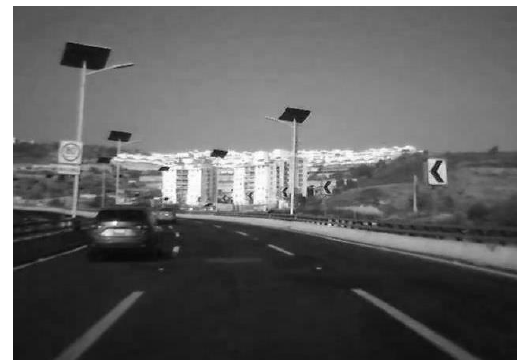
Figure 5. Saturation channel S of colour space HLS of the original image.